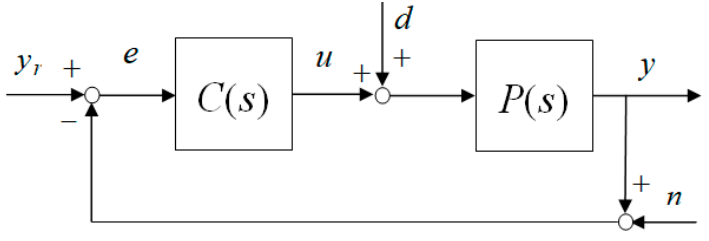
Figure 1. The basic PID control system.